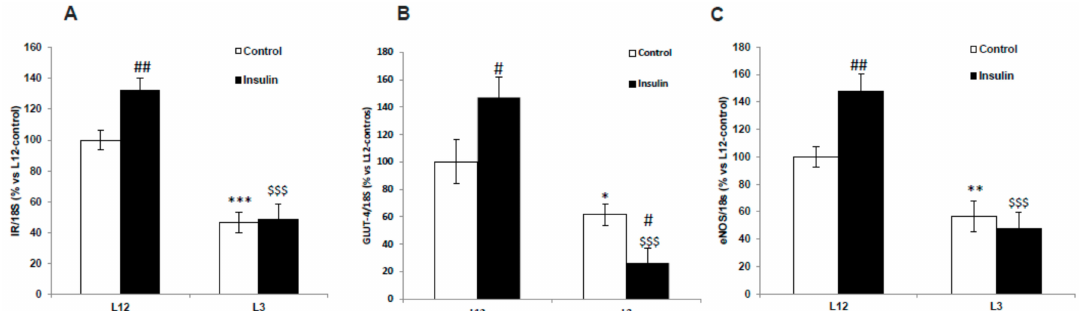
Figure 8. Gene expression of ( A ) insulin receptor (IR), ( B ) glucose transporter 4 (GLUT-4), and ( C ) endothelial nitric oxide synthase (eNOS) in aortic rings incubated for 30 days with vehicle (control) or insulin (10-7 M), from rats raised in L12 or L3 litters. Note: * p < 0.05; ** p < 0.01 *** p < 0.001 di ff erence between aortic rings from L3 and L12; # p < 0.05; ## p < 0.01 di ff erence between hearts incubated with insulin and control; $$$ p < 0.001 di ff erence between aortas incubated with insulin from L3 and L12. Values are represented as mean ± SEM ( n = 6–9 rats / experimental group) and expressed as % vs. L12. All samples were run in duplicate. Data were analyzed by two-way ANOVA followed by Bonferroni post-hoc test.